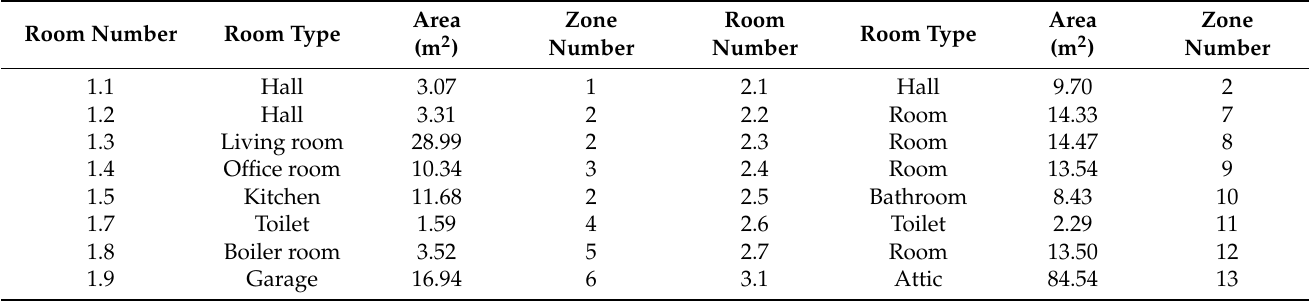
Figure 1. Plan of stories in the analyzed building. Table 1. List of rooms in the analyzed